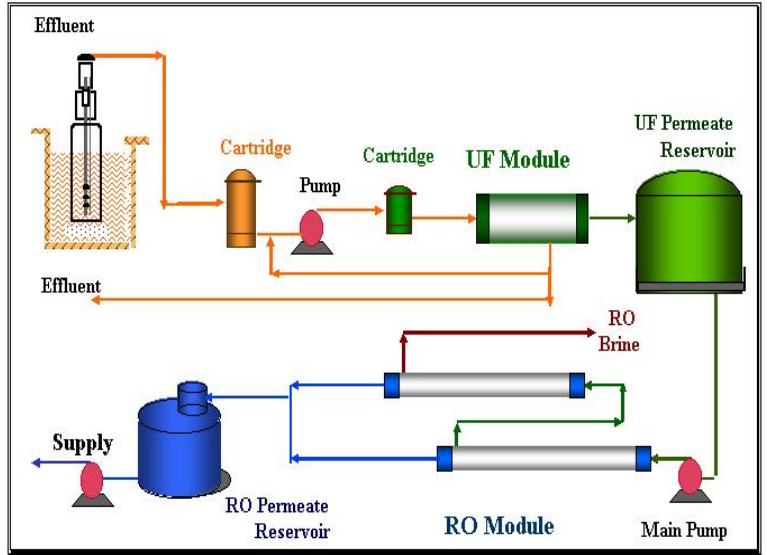
Figure 1. Pilot plant layout for secondary effluent polishing.